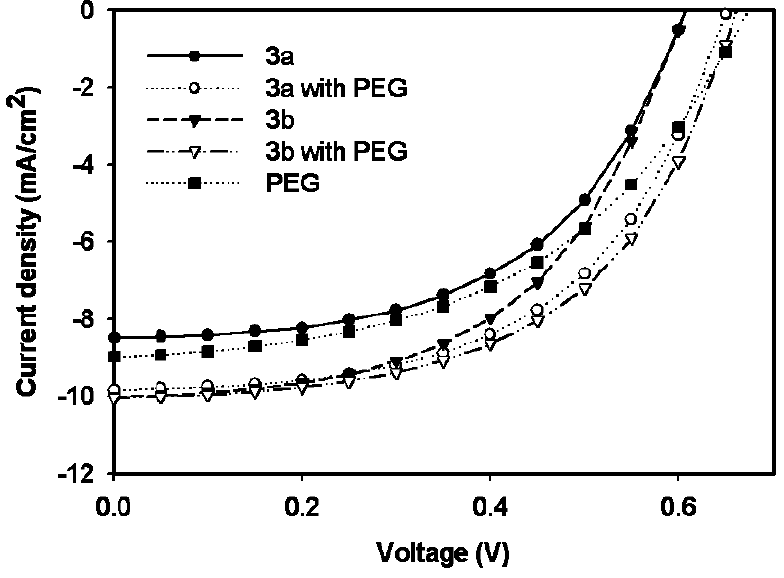
Figure 6. I-V curves of FTO/TiO /Dye/Electrolyte/Pt devices using 3a , 3a with PEG, 3b , 2 3b with PEG, and PEG under AM 1.5 illumination; light intensity: 100 mW/cm 2 ; active area: 0.25 cm 2 ; with mask.